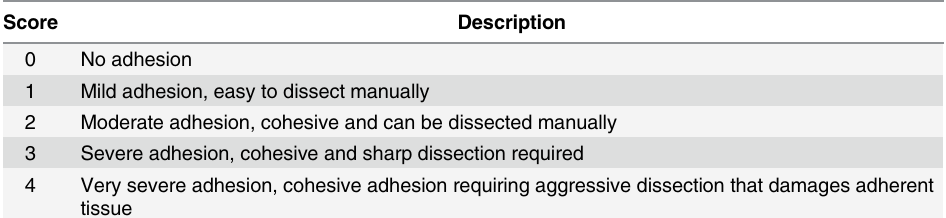
Table 1. Adhesion Score System for Macroscopic Evaluation.